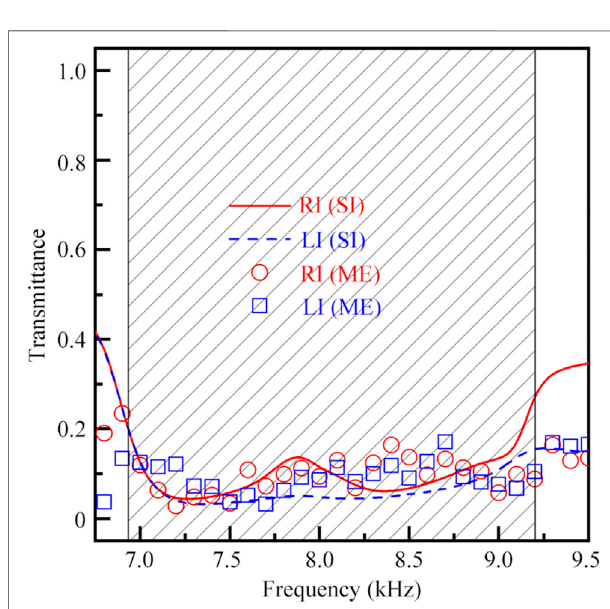
FIGURE 4 | Simulated and measured transmittance spectra created by the BAI lens under the incidence of the zero-order wave for RI and LI.